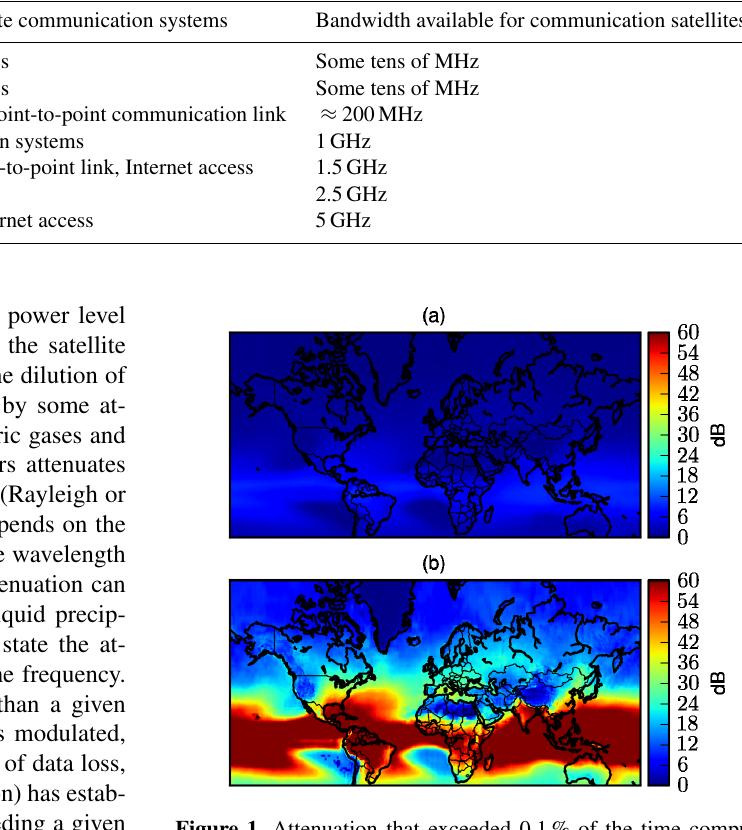
Table 1. Frequency bands used for satellite communications. More details in IEEE (2003).